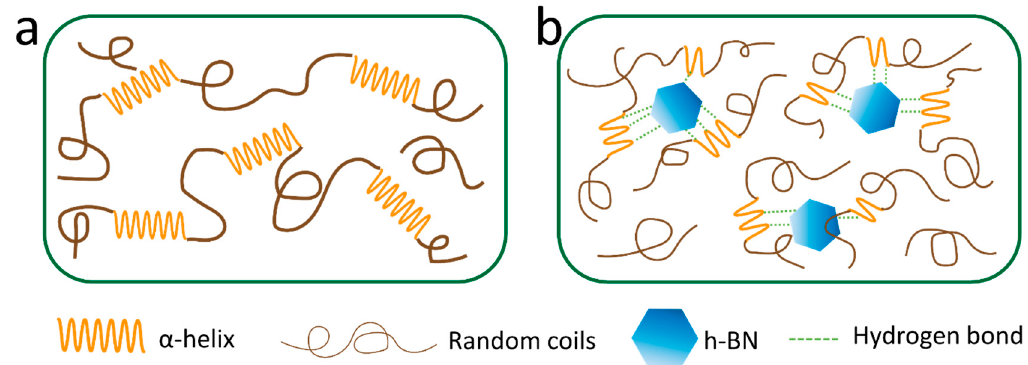
Figure 5. Self ‐ assembled structures of ( a ) electrospun pure SF nanofibers; ( b ) electrospun BNSF nanofibers, showing that the BN nanosheets disrupted the secondary structures of silk fibroin